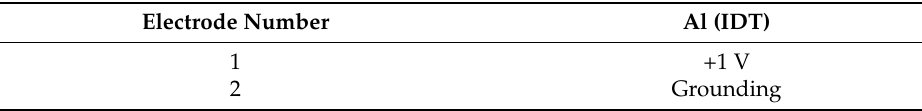
Table 5. Electrode polarity of IDT in the simulation